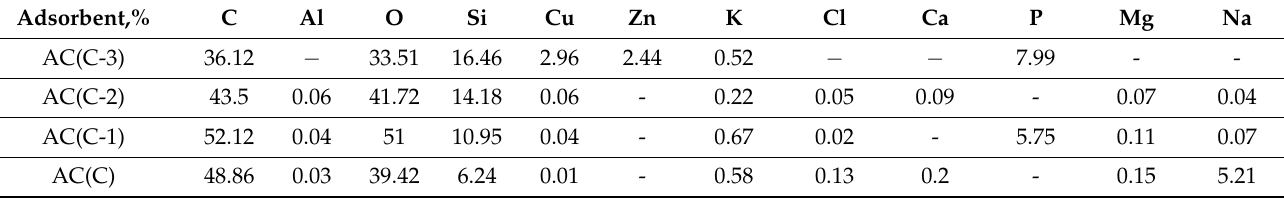
Table 4. Elemental analyses of selected activated